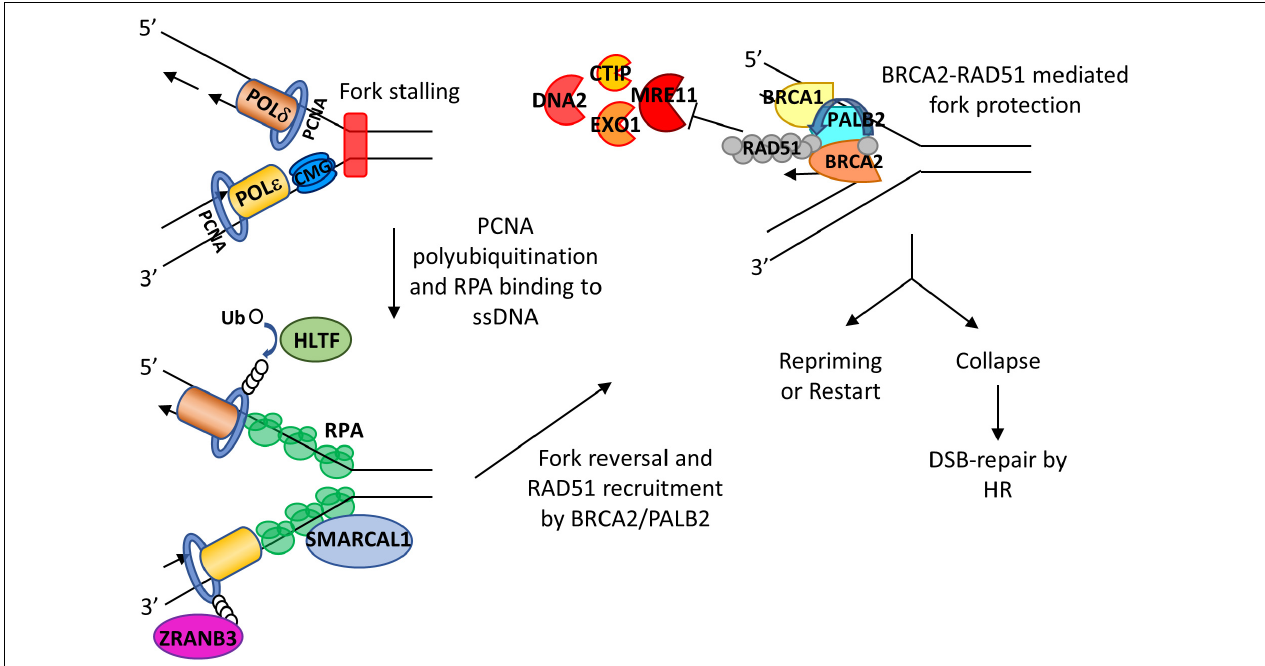
FIGURE 3 | Roles of RPA and BRCA2 in fork reversal and fork protection. RS leads to fork slowing and fork reversal by SNF2 family chromatin remodelers SMARCAL1, ZRANB3, and HLTF. HLTF polyubiquitinates PCNA and thus leads to the recruitment of ZRANB3. SMARCAL1 directly interacts with RPA on the leading strand, and RPA controls the fork remodeling activity of SMACARL1. After fork reversal and RPA phosphorylation, PALB2 binds to RPA and recruits BRCA2. BRCA2 recruits RAD51 with assistance of PLK1 and mediates replacement of RPA with RAD51, leading to fork protection from nucleases such as MRE11, EXO1, CTIP, and DNA2. The fork can then be reprimed or restarted. When undergoing sustained RS, stalled forks may collapse, leading to DSBs that can be subsequently repaired by HR.